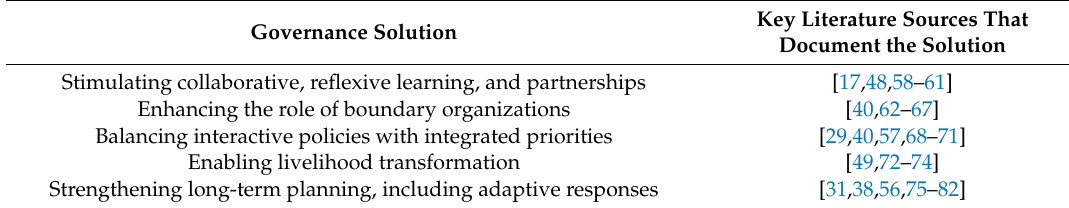
Table 3. Key governance solutions identified in the literature